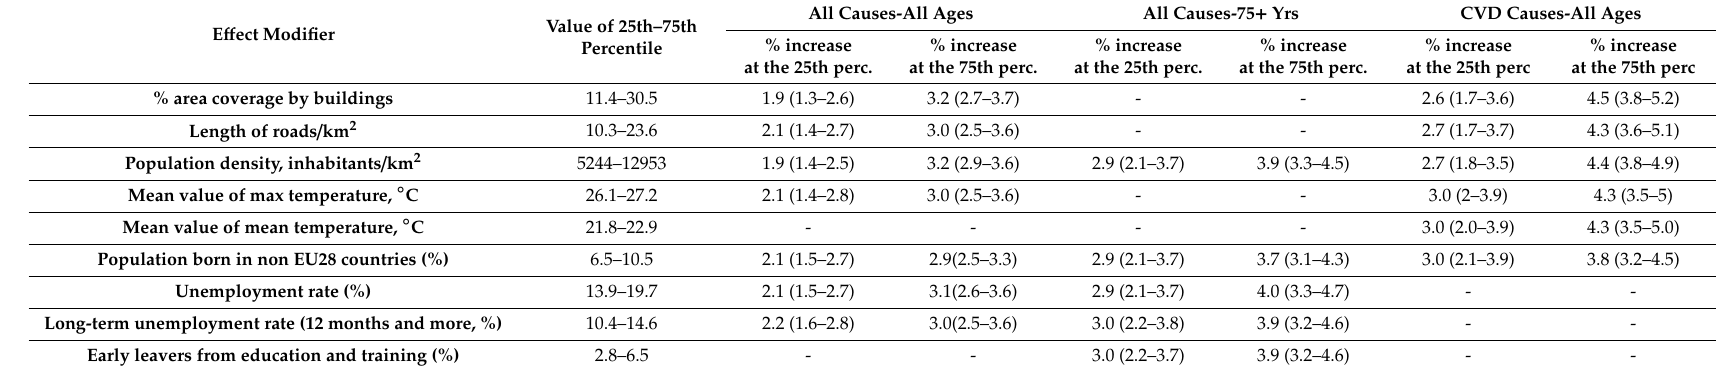
Table 4. % increase in daily number of deaths per 1 ◦ C increase in maximum daily temperature, at the 25th and 75th percentile of the distribution of identified e ff ect modifiers, by cause of